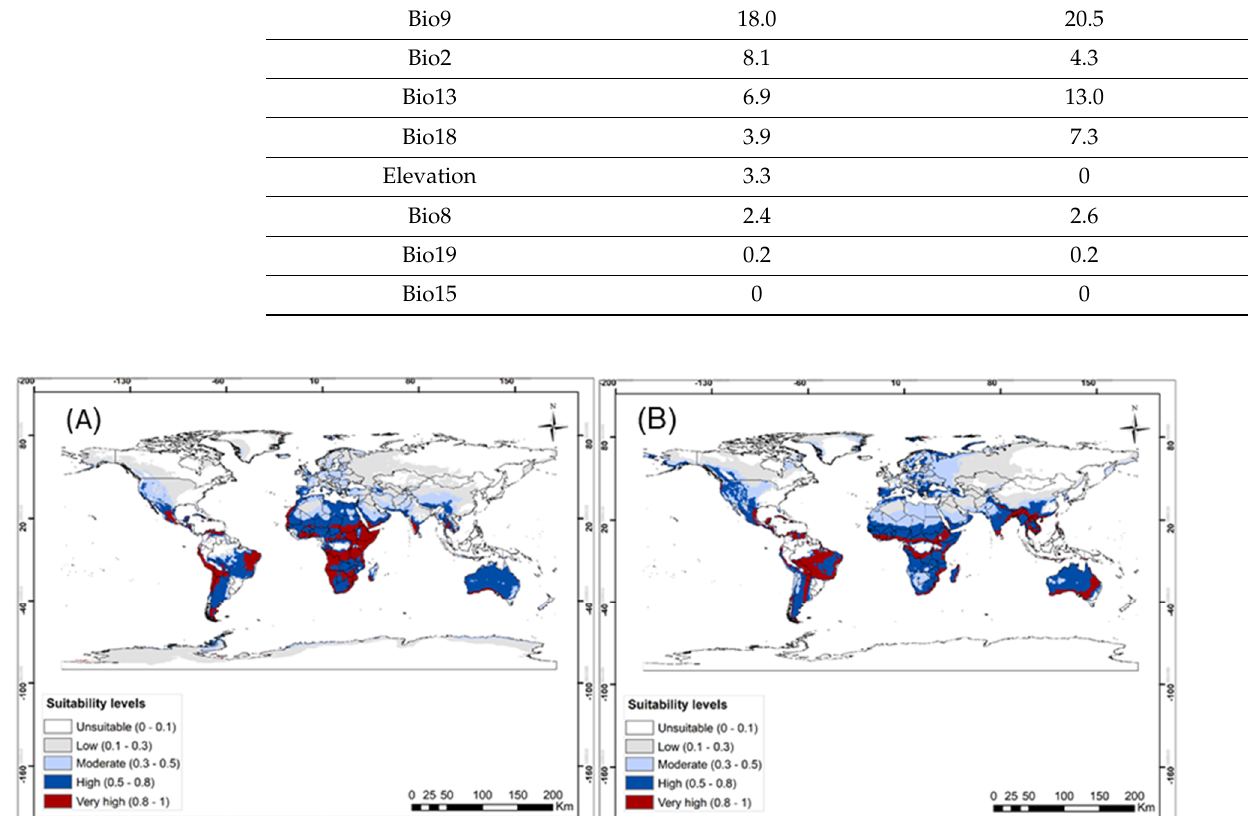
Figure 5. Probable bioclimatic suitability of Bracon nigricans under ( A ) current, and ( B ) representative concentration pathways (RCP2.5) of 2050 climate scenarios.